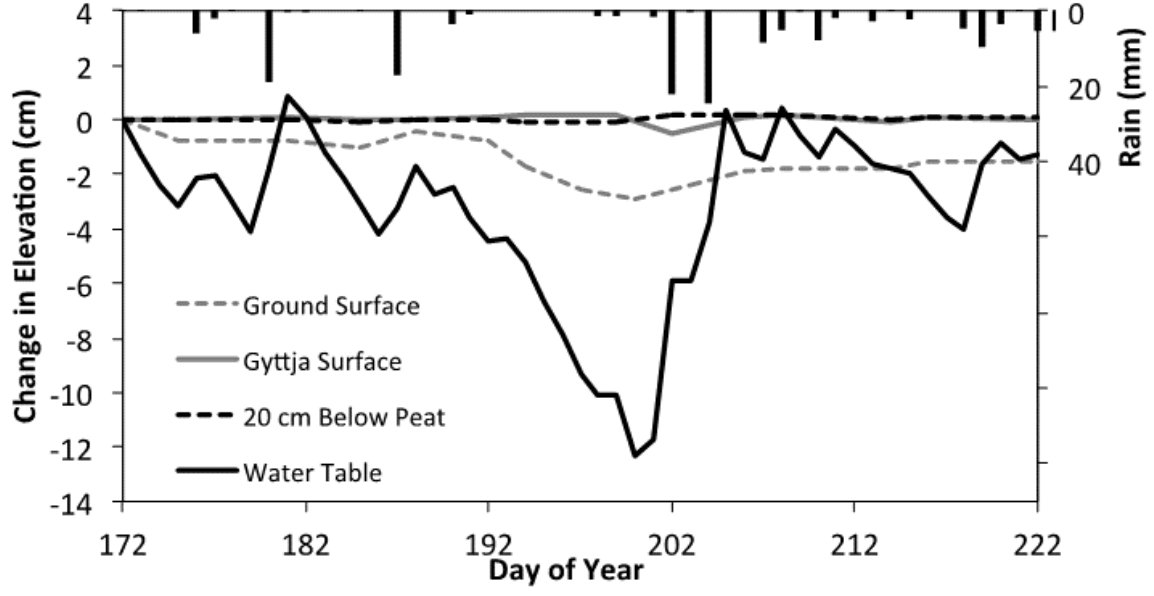
Figure 3. Peat and gyttja subsidence and water table movement at the interior site. The initial (Day 172) water table level was + 5